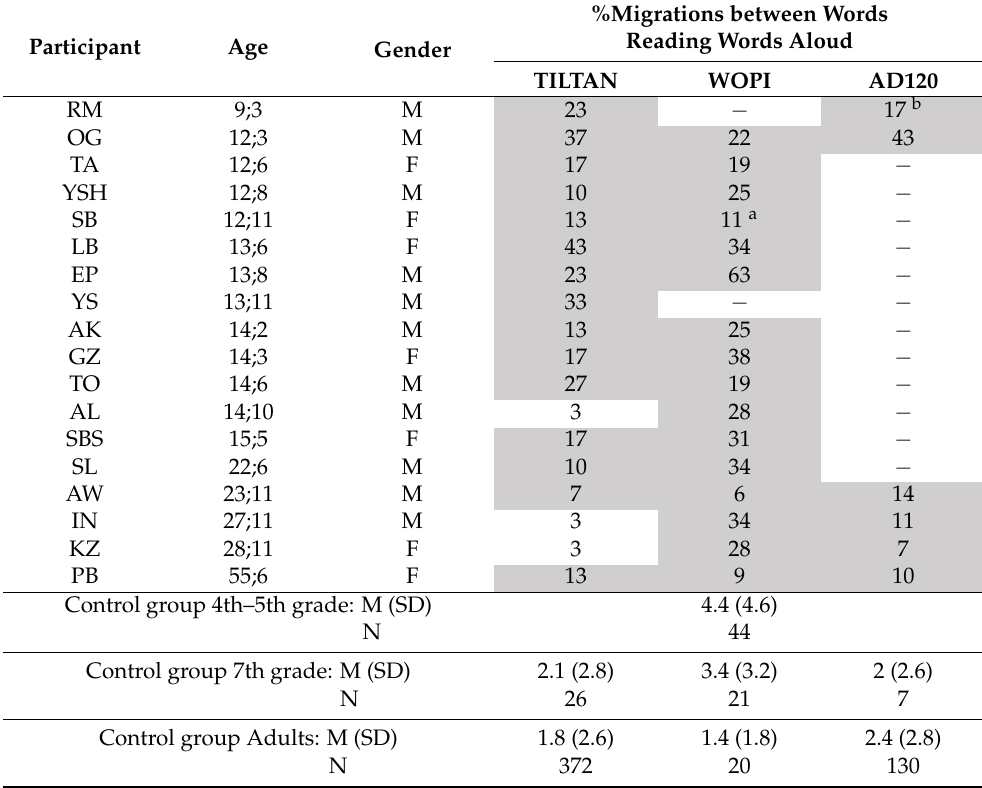
Table 1. The three word-pair reading aloud tests: %migrations between words out of the number of word pairs the participant